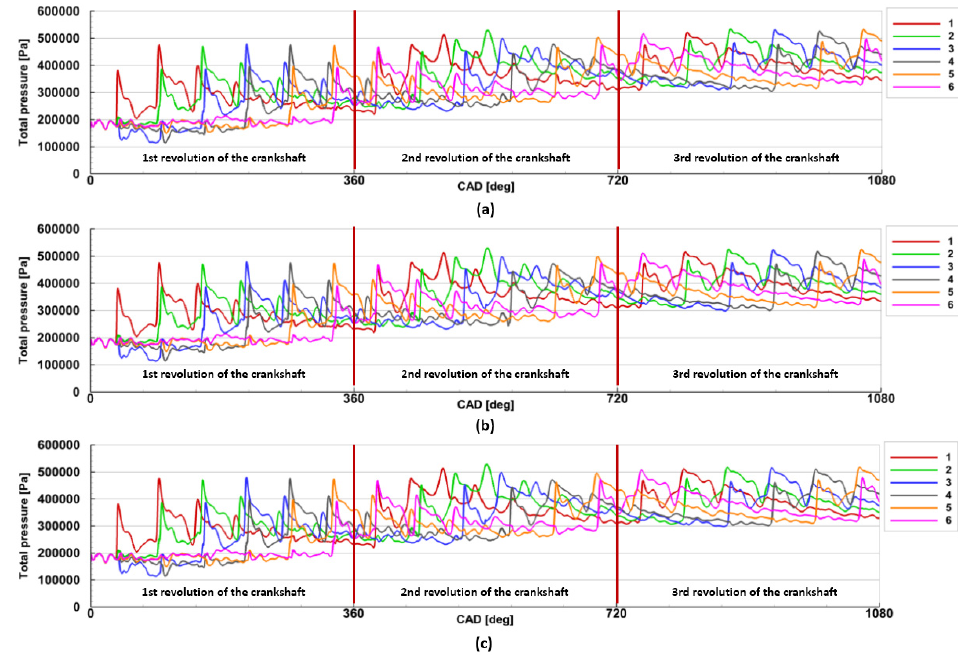
Figure 10. The plot of the total pressure at the 1-st stage turbine inlet for the 11° VTG opening at: ( a ) 60,000 rpm , ( b ) 50,000 rpm , ( c ) 40,000 rpm turbine speed.